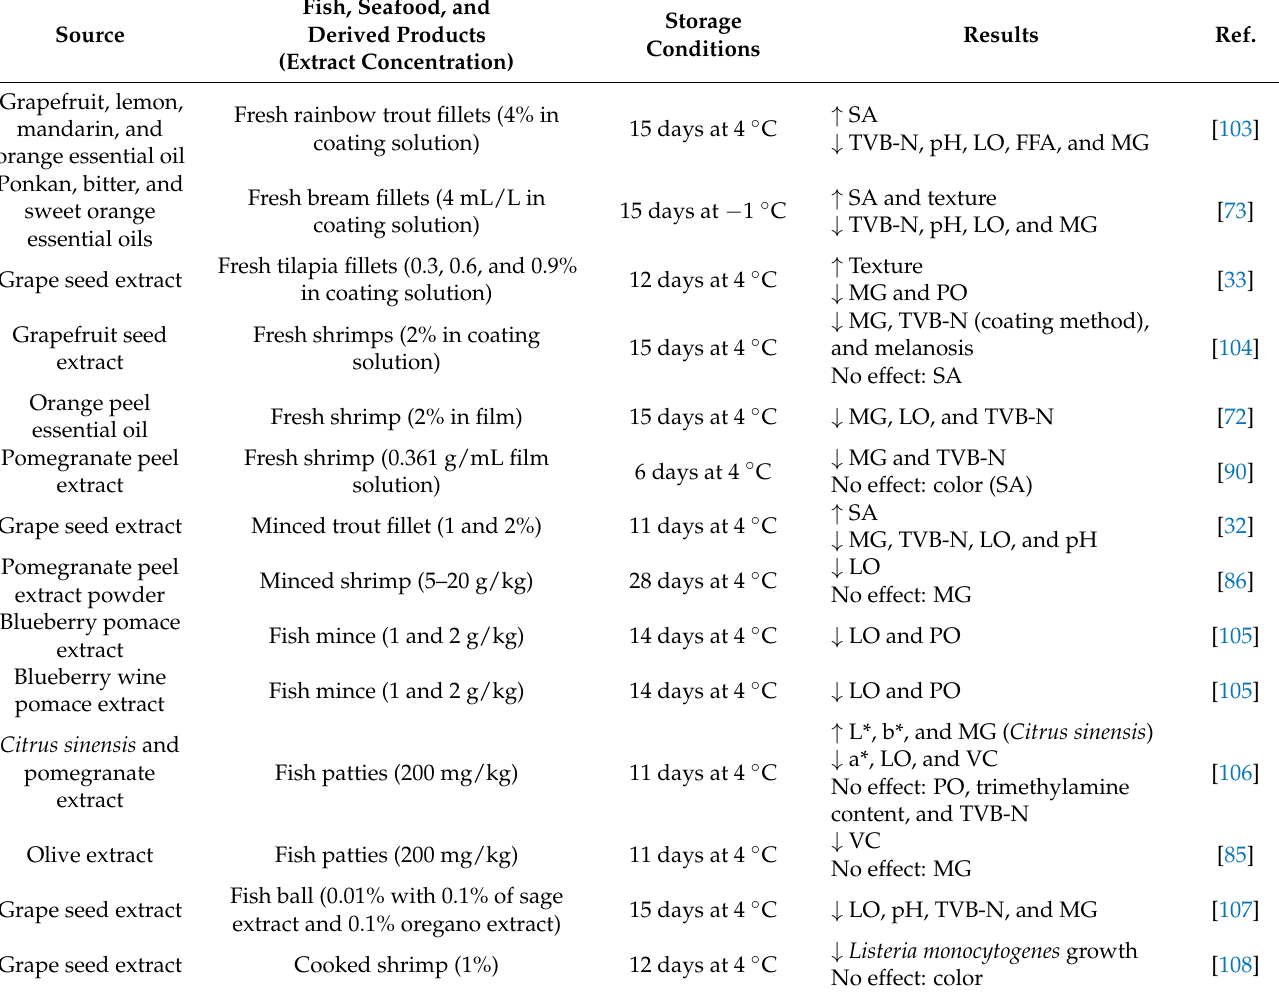
Table 5. Preservative effect of fruit bioactive compounds in fish, seafood, and derived